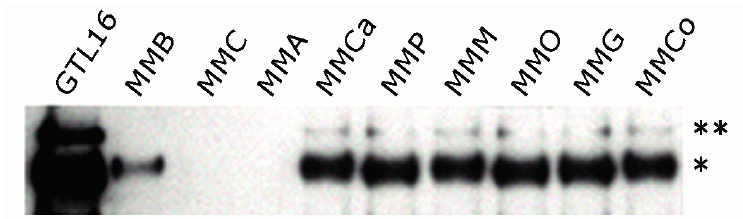
Figure 2. Expression of Met in different MM (Malignant mesothelioma) cell lines. Immunoprecipitation with Met antibodies, followed by immunoblotting with the same antibodies. Asterisks on the right indicate the Met precursor (pr170 MET , **) and the mature β -chain (p145 MET , *). GTL16 are gastric carcinoma cells bearing Met amplification and overexpression (control). Modified from